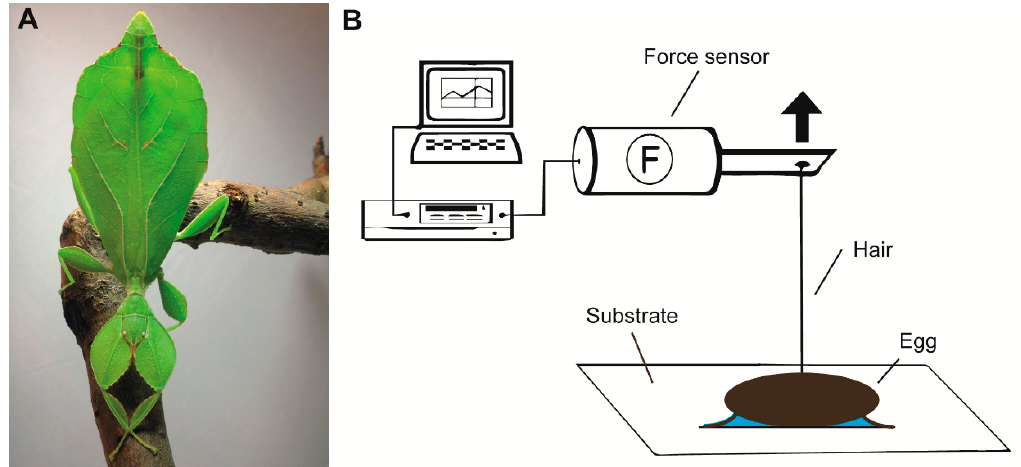
Figure 1. Examined species and experimental setup. ( A ) Female of Phyllium philippinicum (image is provided by Daniel Dittmar). ( B ) Experimental set-up for detachment force measurements. The egg, which was glued onto the particular substrate fixed on a lab boy using double-sided sticky tape. A hair was glued onto the egg and connected to a force sensor. To detach the egg from the substrate, the force sensor was moved away from the egg in perpendicular direction. The time force signal was amplified and finally processed in a computer.